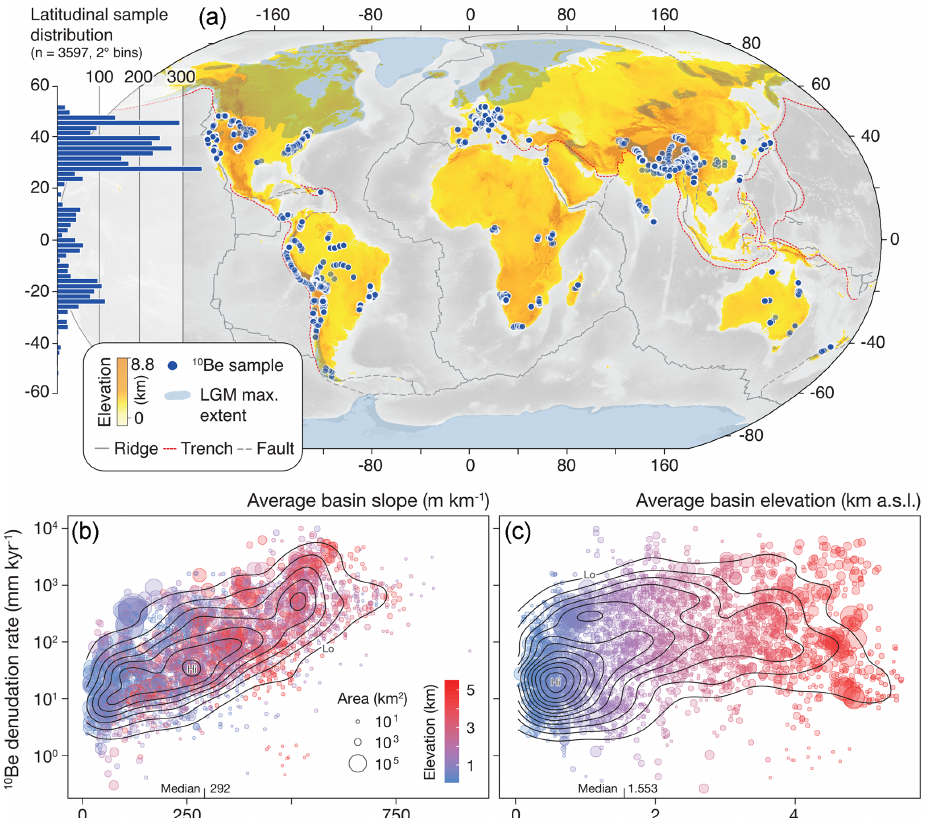
Figure 7. The global CRN data set: (a) geographical extent and latitudinal sample distribution, (b) average basin slope versus recalculated 10 Be denudation rate, and (c) average basin elevation versus recalculated 10 Be denudation rate. Data points in (b) and (c) are coloured according to average basin elevation and circle sizes are proportional with basin area. Contour lines show kernel density estimates for the point clouds (arbitrary